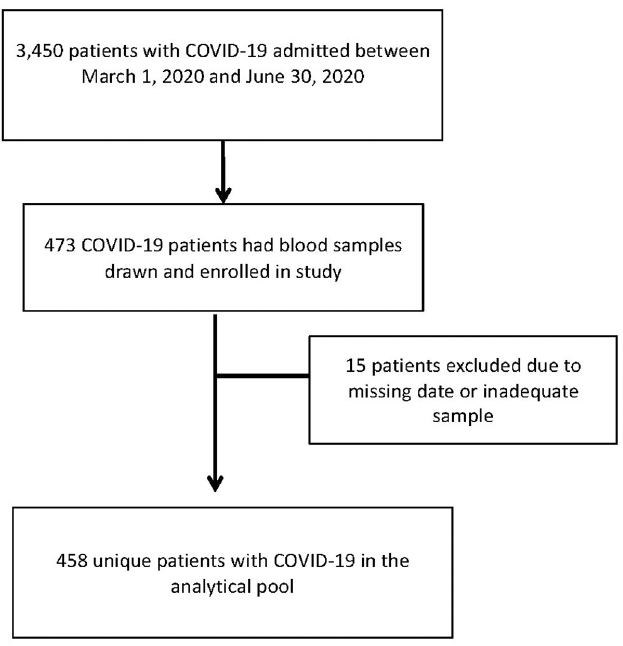
Fig 1. Flow chart of study patients from all COVID-19 admissions to the institution from March to July 2020.